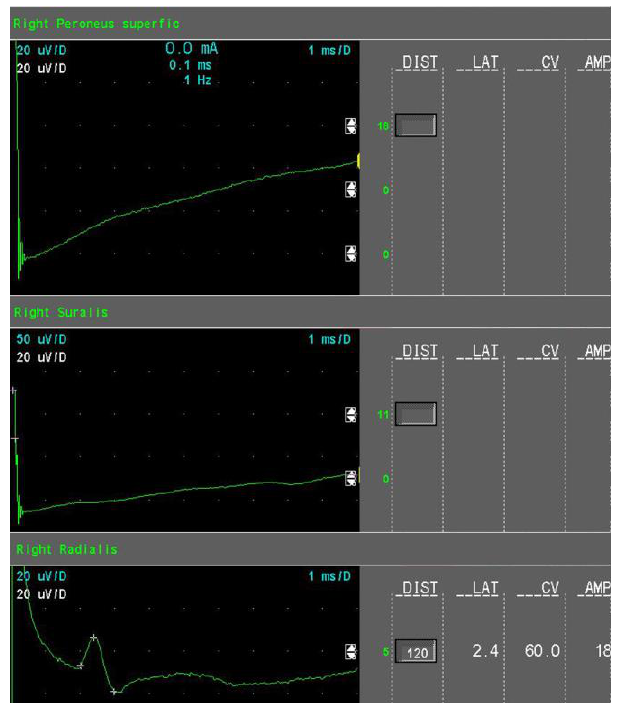
Figure 2. Sensory nerves conduction studies in moderate sensory axonal loss (example).